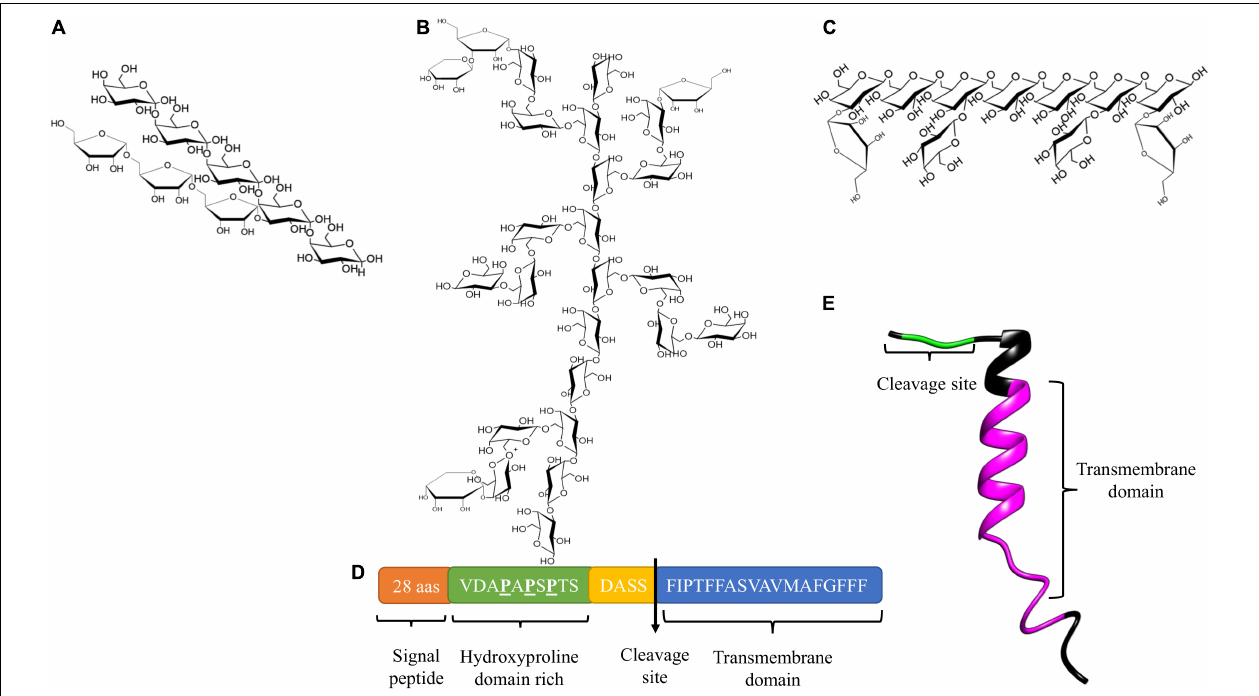
FIGURE 1 | Structure of AGs and AGPs. (A) Structure of AG Type I. (B) Structure of AG Type II. (C) The third type of structure reported for AGs, (D) Protein core of At AGP14 (Accession number: AAG24282). (E) Three-dimensional structure model of At AGP16 (Accession number: